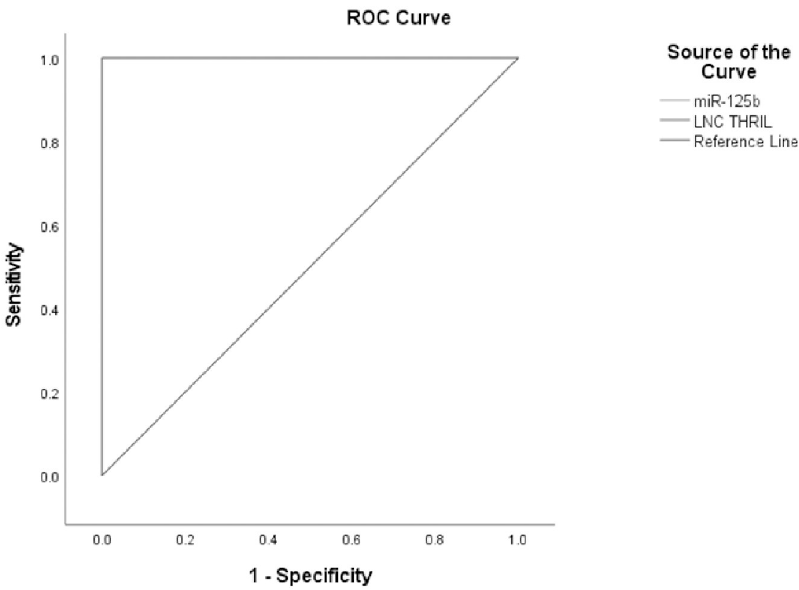
Fig 1. Receiver operating characteristic of sensitivity and specificity of Lnc THRIL and MiR-125b in UC patients vs. controls.